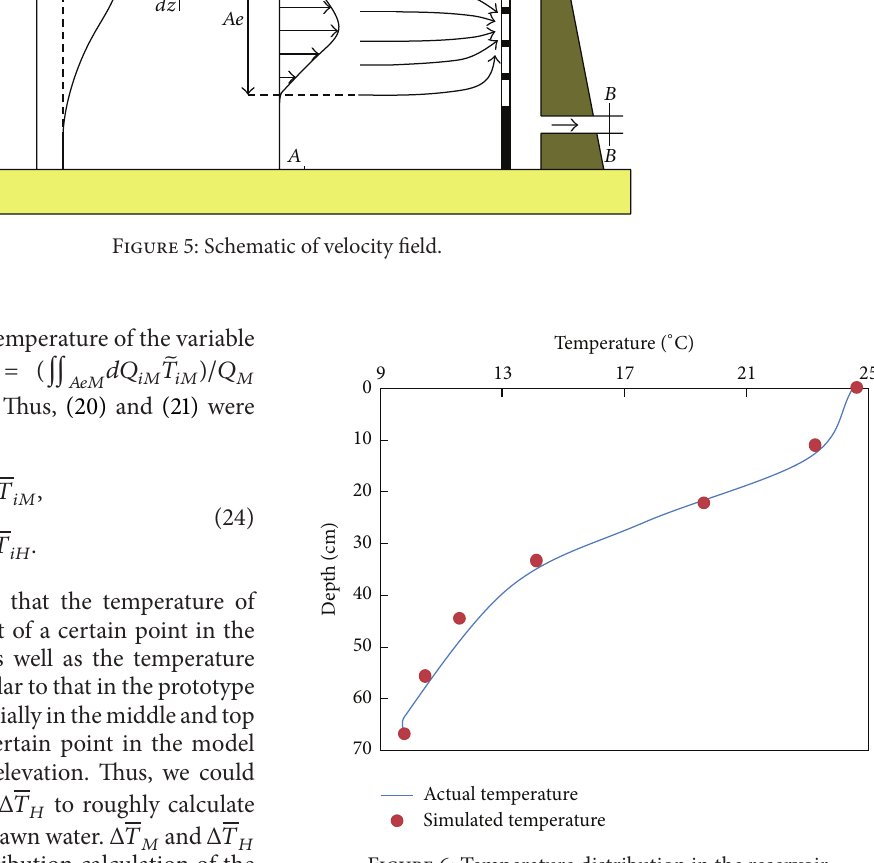
Figure 6: Temperature distribution in the